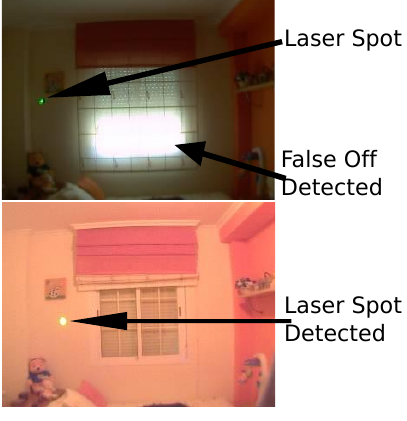
Fig. 2. False off and success using the DU